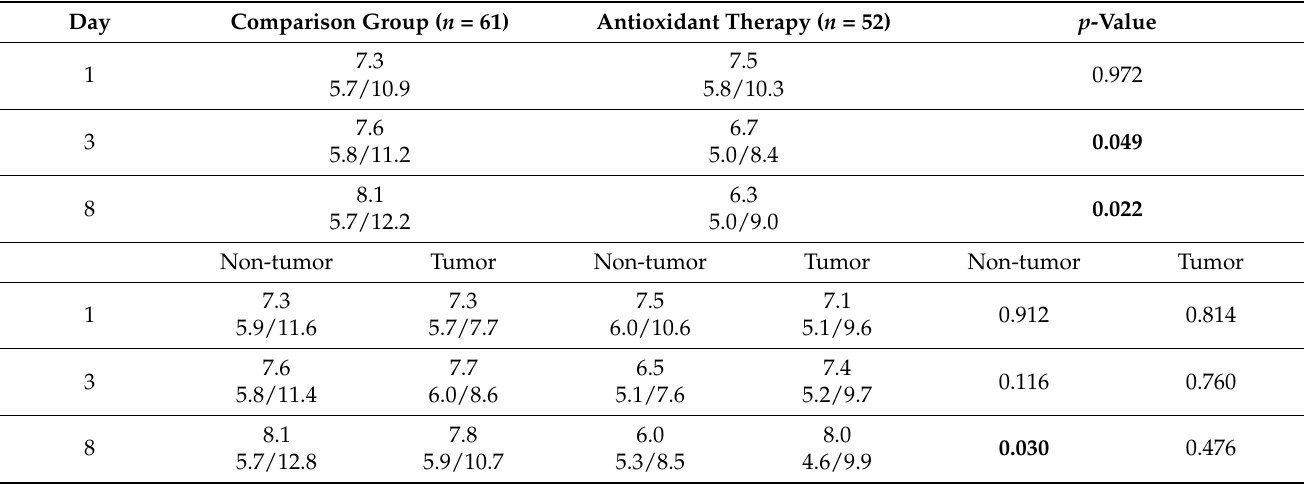
Non-tumor Tumor